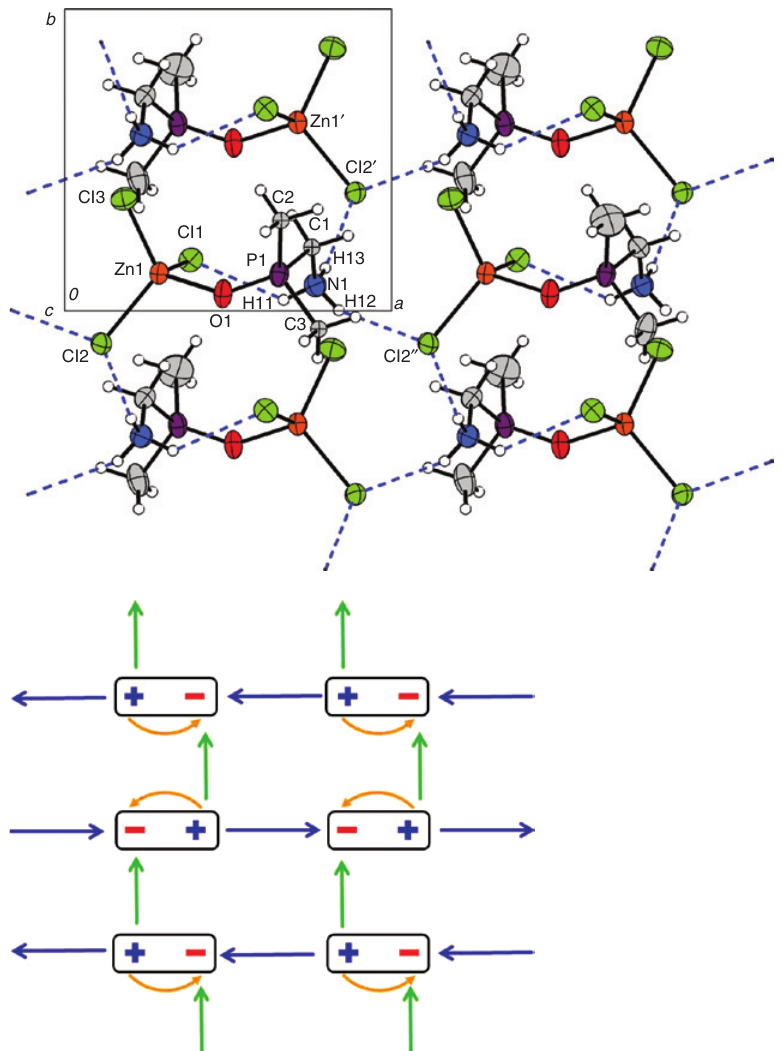
Figure 2: Upper part: the crystal structure of the monoclinic polymorph 6a is shown along [00-1]. Hydrogen bonds are indicated by blue fragmented lines. Ellipsoids are drawn at the 40% probability level. Symmetry codes: ′ = 1- x , 0.5 + y , 0.5- z ; ″ = 1 + x , y , z . Lower part: the constructor graph of the hydrogen-bonded connection of the title complex in 6a is shown; crystallographically related hydrogen bonds are coded by their